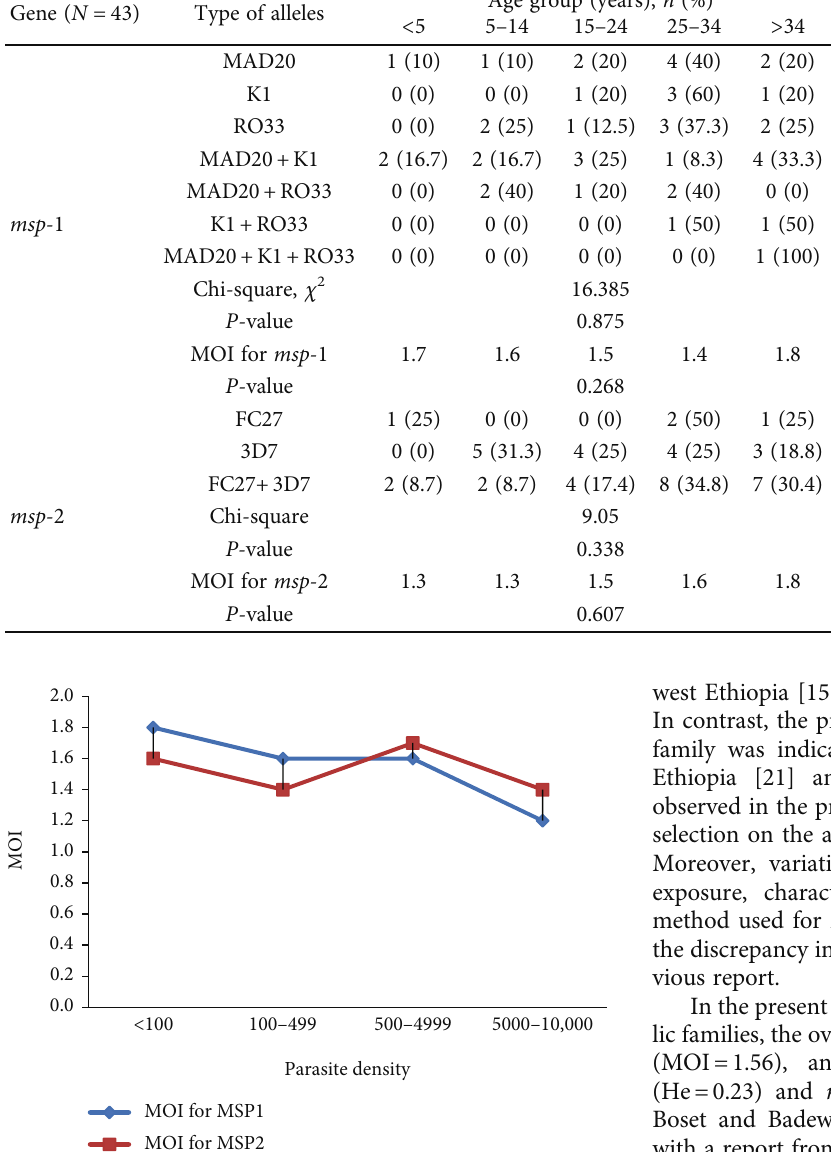
Table 4: Distribution of Plasmodium falciparum msp -1 and msp -2 allelic family pro fi le by age groups, sex, and study site. Age group (years), n (%) Gene ( N = 43 ) Type of alleles